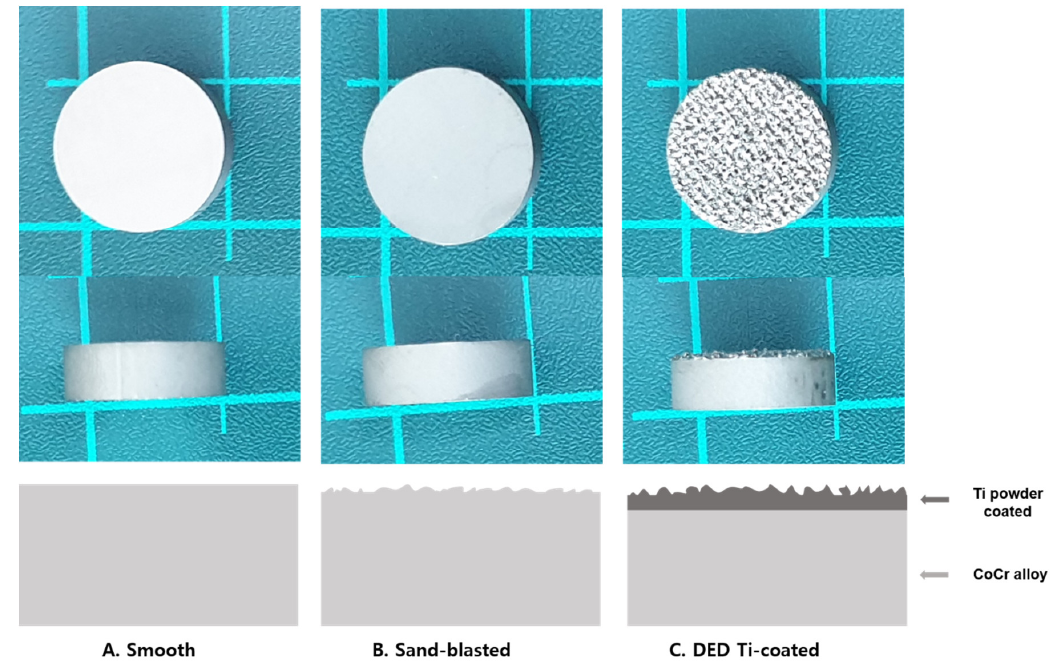
Figure 1. Photo viewed from the front and lateral side of each specimen and a schematic diagram used for experiments A: smooth, B: sand-blasted, C: direct energy deposition (DED)-Ti coated. (Black color: Cobalt Chrome alloy, Red color: Ti powder coating).